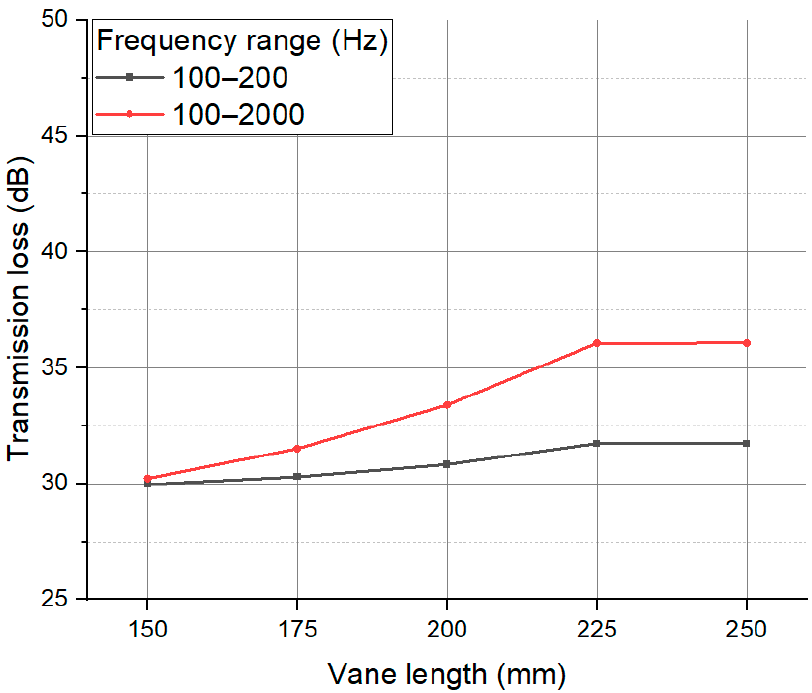
Figure 9. Average transmission loss according to the vane length in the inner vane type.